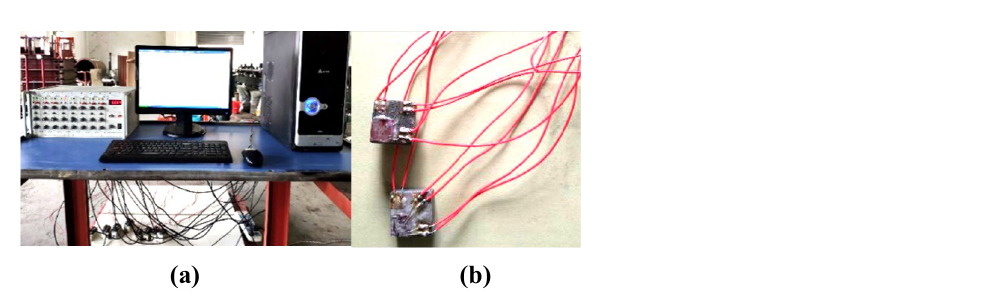
Figure 5. Experimental data monitoring system and strain brick used in this study: ( a ) test data monitoring system, and ( b ) strain